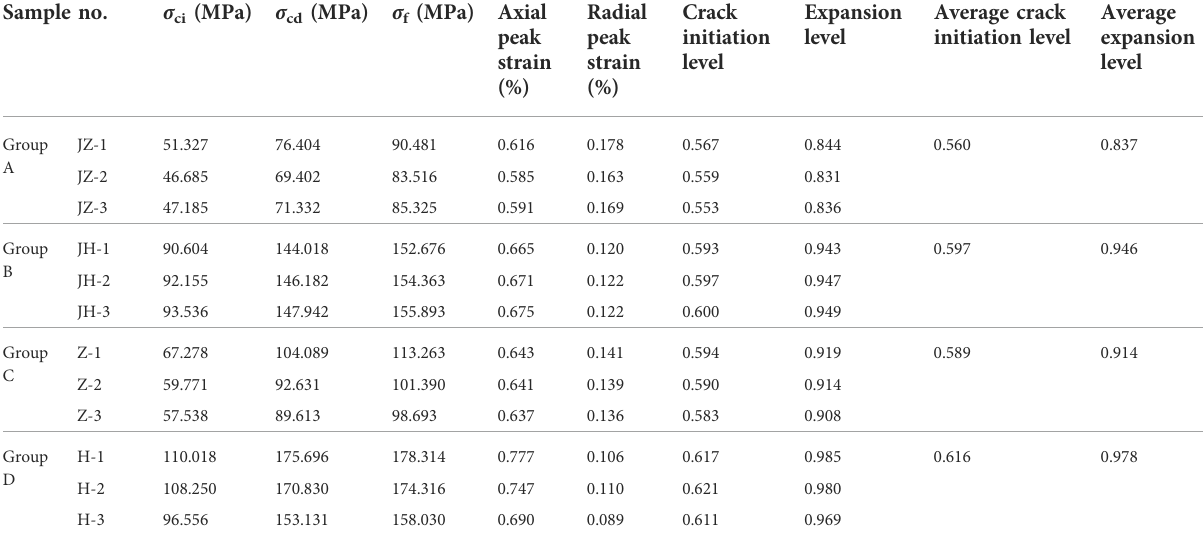
TABLE 2 Characteristic parameters of compression process. Sample no.